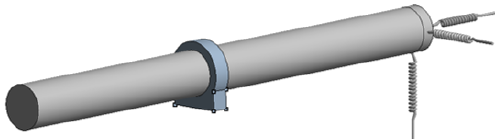
Figure 4. The three-dimensional finite-element model with double- row tapered-roller-bearing-type reaction